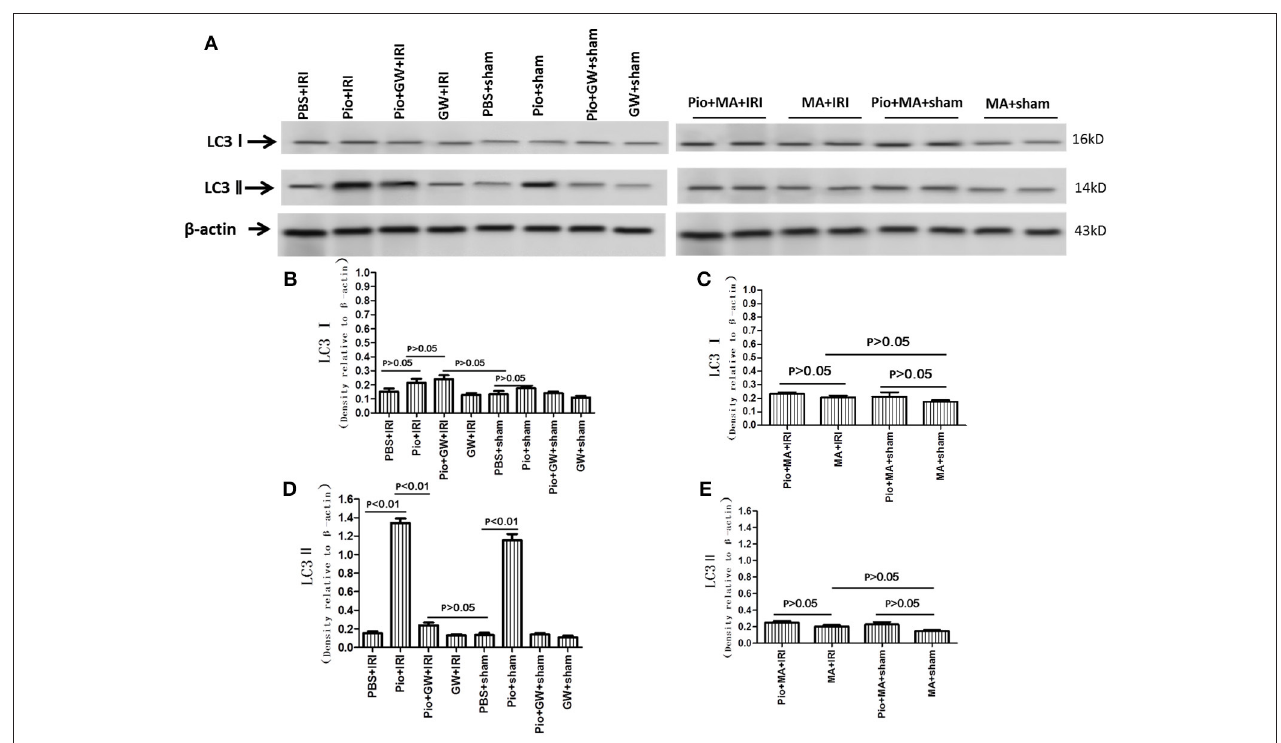
FIGURE 7 | Expression of LC3 I and LC3 II proteins at 24h after renal IRI. (A) Representative western blots show LC3 I and LC3 II protein levels in the kidneys. (B–E) Quantitative analysis of LC3 I and LC3 II protein levels in the kidneys. Values are expressed as means ± SE (B–E) . n = 6 in each group.